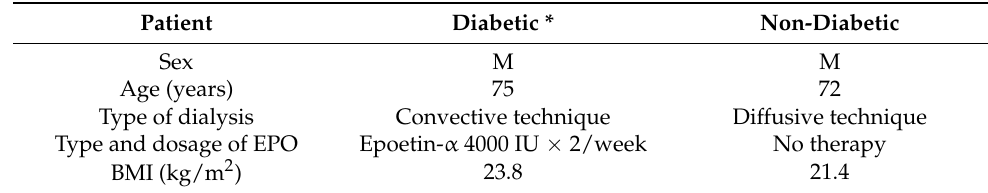
Table 2. Features of the two patients, one diabetic and one non-diabetic. Abbreviations: BMI, body